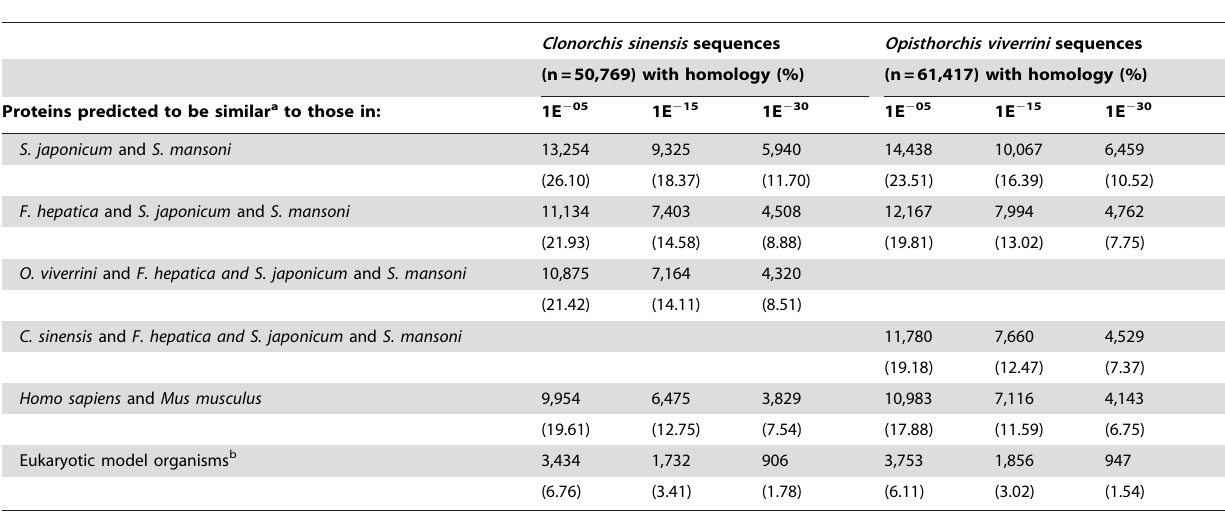
Table 4. Comparative genomic analysis between or among Clonorchis sinensis, Opisthorchis viverrini , Fasciola hepatica , Schistosoma mansoni , S. japonicum (blood flukes) and selected mammals.